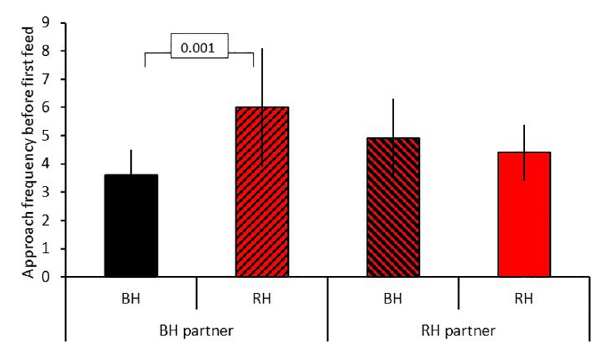
FIGURE 3 | Effect of partner head color on approach frequency before first feed (mean(SE) for red-headed (RH) and black-headed (BH) birds. Numbers in the figure represent p-values; black bars = black-headed pairs, hatched bars = mixed head color pairs, red bars = red-headed